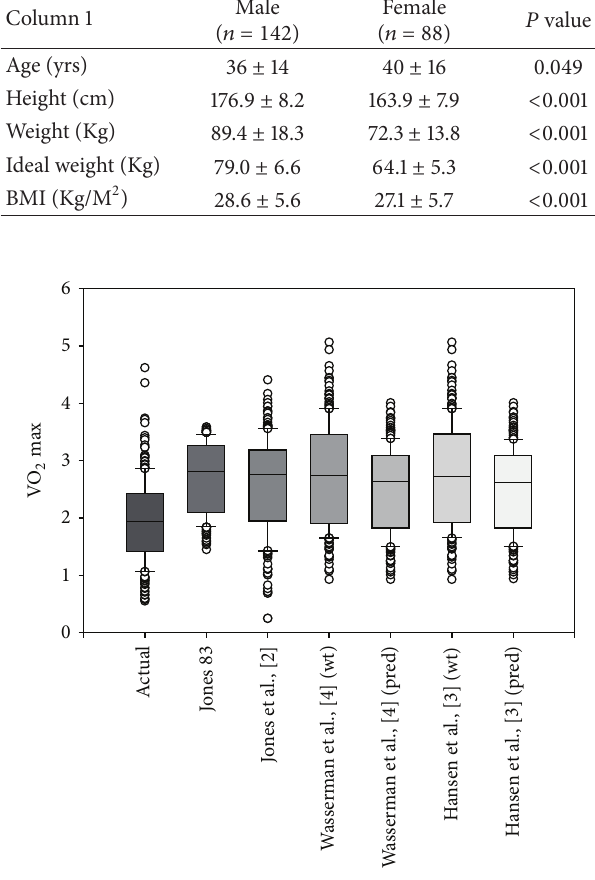
Figure 1: Figure indicates significant overestimation of predictors of VO 2 max compared with actual measured VO 2 max in this population. Significant differences among test (𝑃 ≤ 0.001)